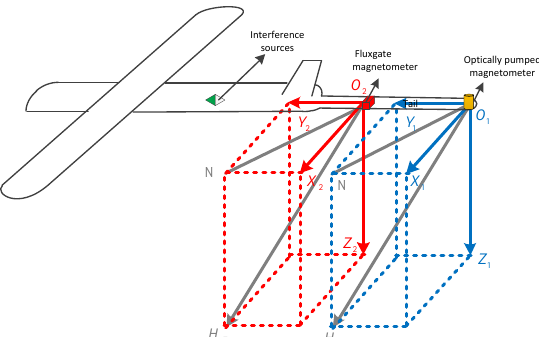
Figure 2. Sensor installation method and coordinate system